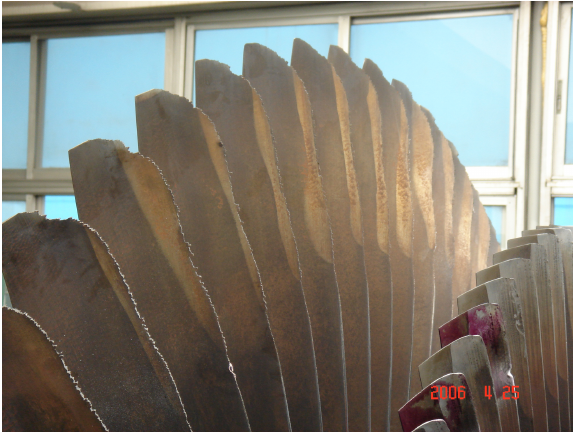
Figure 1. Extremely damaged turbine blades.